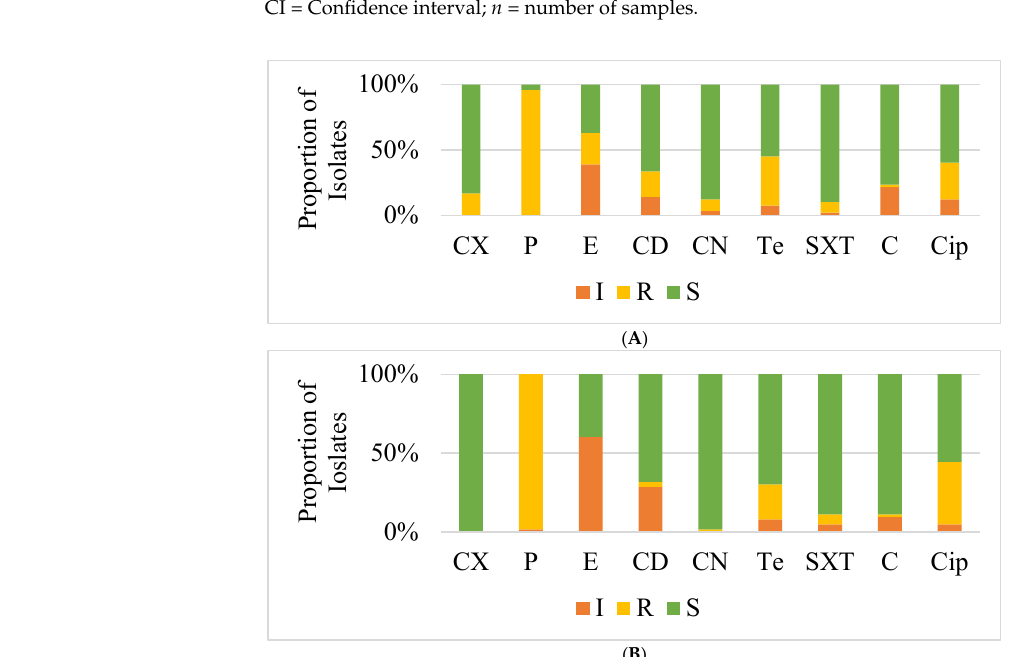
Figure 1. Overall Antimicrobial Susceptibility Profiles of S. aureus Isolates from pigs and workers from Farms ( A ) and Abattoirs ( B ) of Lusaka Province. Abbreviations: P = Penicillin; CN = Gentamicin; E = Erythromycin; CD = Clindamycin; Cip = Ciprofloxacin; Te = Tetracycline, SXT = Cotrimoxazole, C = Chloramphenicol, CX = Cefoxitin; I = Intermediate, R = Resistant, S = Susceptible.